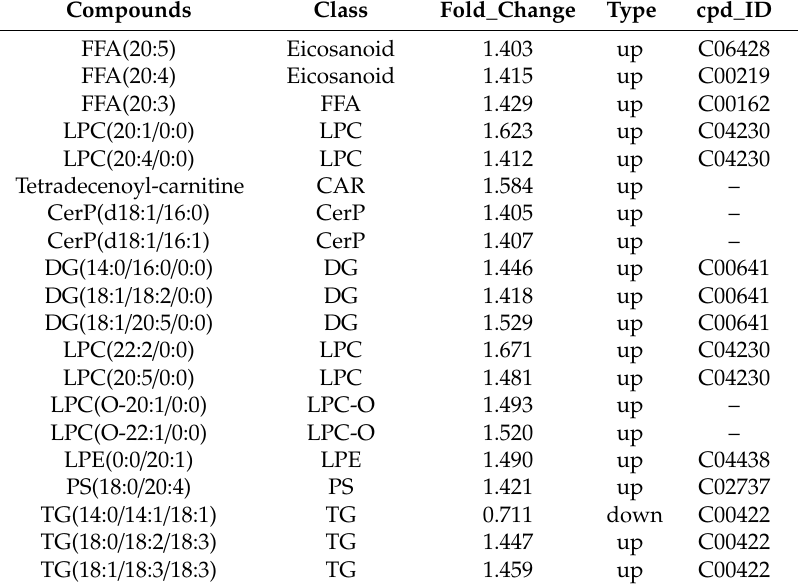
Figure 3. Lipid metabolome sequencing: ( a ) heat map; ( b ) volcano plots; ( c ) KEGG analysis; ( d ) the detection of intracellular diglyceride content (* p < 0.05). NC: Adipocytes transfected with pcDNA3.1(+) vector as control. Over-ACSL1: Adipocytes transfected with pcDNA3.1(+) vector with ACSL1 CDS. Table 1. The differential metabolites in adipocytes overexpressing the ACSL1 gene compared with the controls.